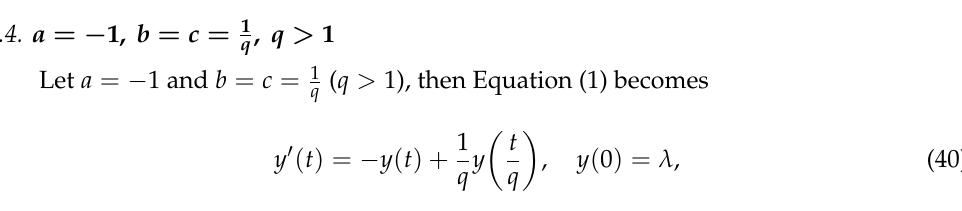
Figure 10. Plots of the exact solution in Equation (36) vs. t at different values of λ when a = 0 and b =